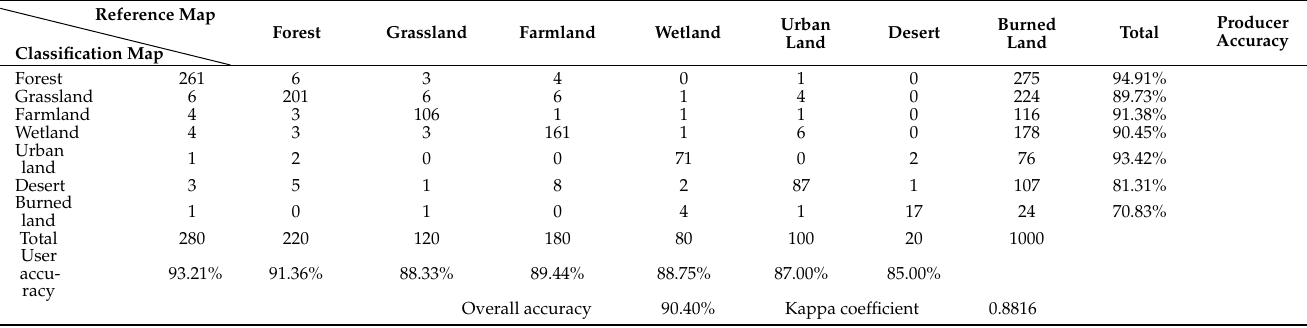
Table A3. Error matrix of land cover classification in